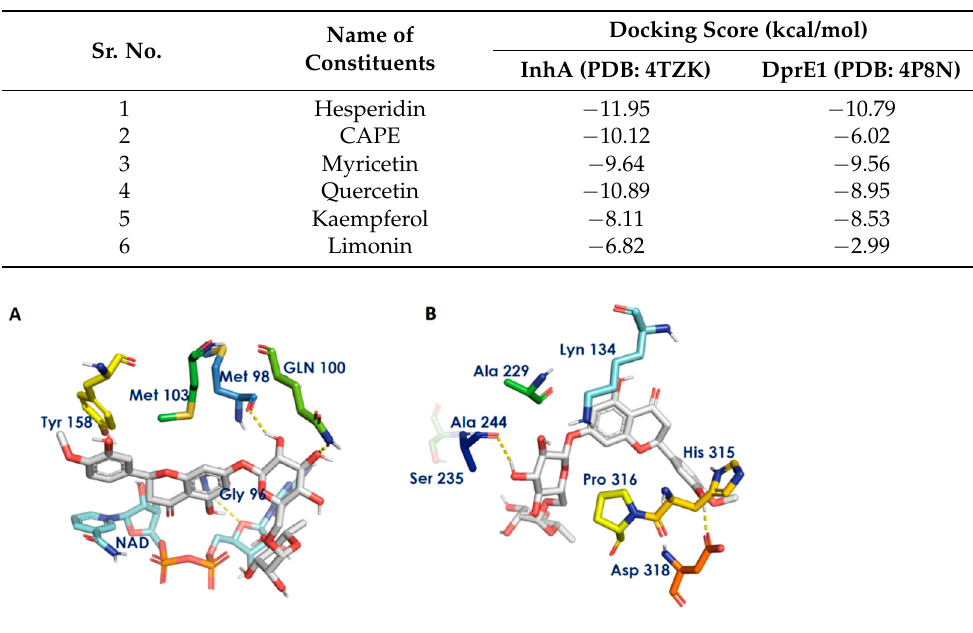
Figure 3. Receptor ‒ ligand interaction diagrams. ( A , B ): Interaction of hesperidin with the active sites of InhA and DprE1, respectively. Gray sticks indicate ligands, atom-type color sticks indicate amino acid residues of receptor and yellow dotted lines represent hydrogen bonds formed between ligands and receptors.